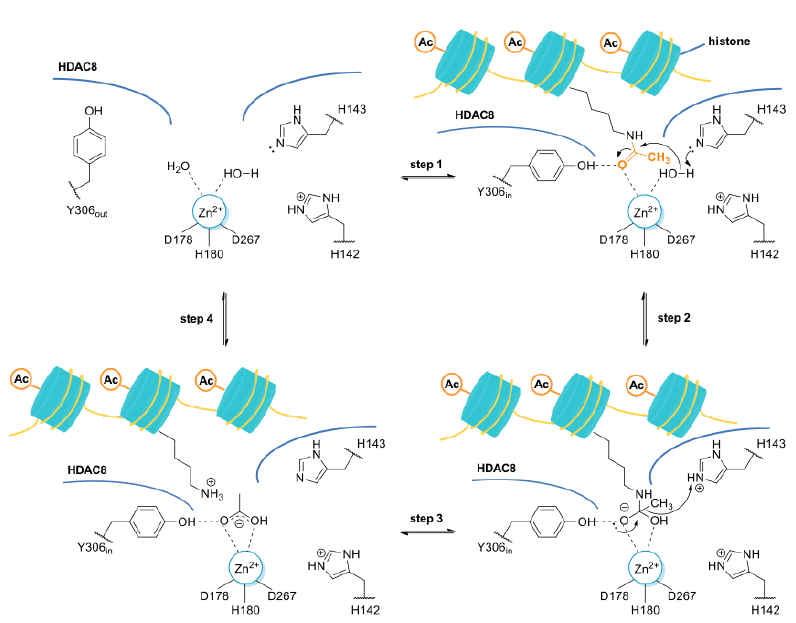
Figure 1. Proposed deacetylation mechanism of N -acetyl lysine residue of histone protein by the HDAC8 enzyme. The residue H143, acting as a base, deprotonates a Zn 2+ -bound water molecule, which, in turn, performs the nucleophilic attack at the Zn 2+ -coordinated carbonyl group of the N -acetyl-lysine (step 1 and 2). The tetrahedral intermediate and its transition states are stabilized by the coordination bond with the Zn 2+ along with the hydrogen bond interactions with Y306, H143, and H142. H143, acting as acid catalyst, assists the rearrangement of the tetrahedral intermediate to give the positively charged lysine (step 3 and 4). It was hypothesized that the side chain of Y306 may undergo conformational changes, adopting the “out” conformation in absence of the substrate, while the “in” conformation is required for the substrate binding and